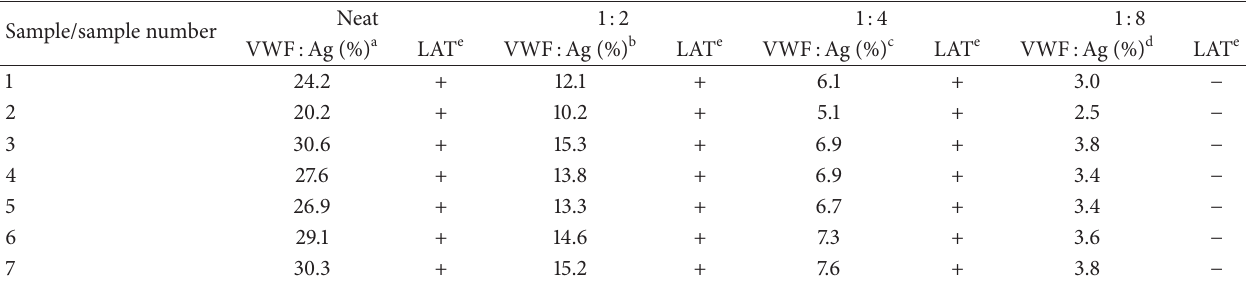
Table 4: Limit of detection of VWF antigen detected by using latex agglutination test. Sample/sample